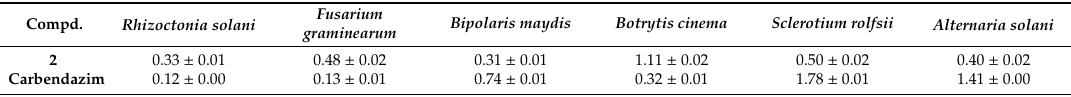
Table 2. The EC 50 values (mmol / L) of compound 2 against six pathogenic fungi. Compd. Rhizoctonia solani Fusarium graminearum Bipolaris maydis Botrytis cinema Sclerotium rolfsii